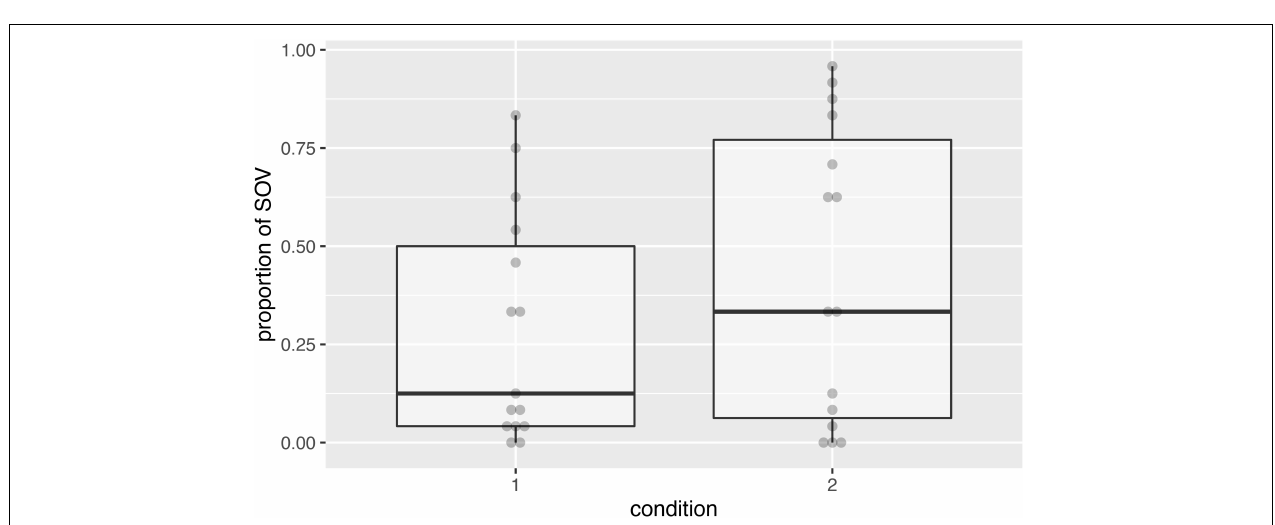
FIGURE 3 | Proportion of SOV responses by type of event. Gray dots represent participants. Strongly non-reversible events elicited more SOV responses than weakly non-reversible events. (Reversible events are displayed for reference, but were not included in the analysis. See data repository for a full analysis).